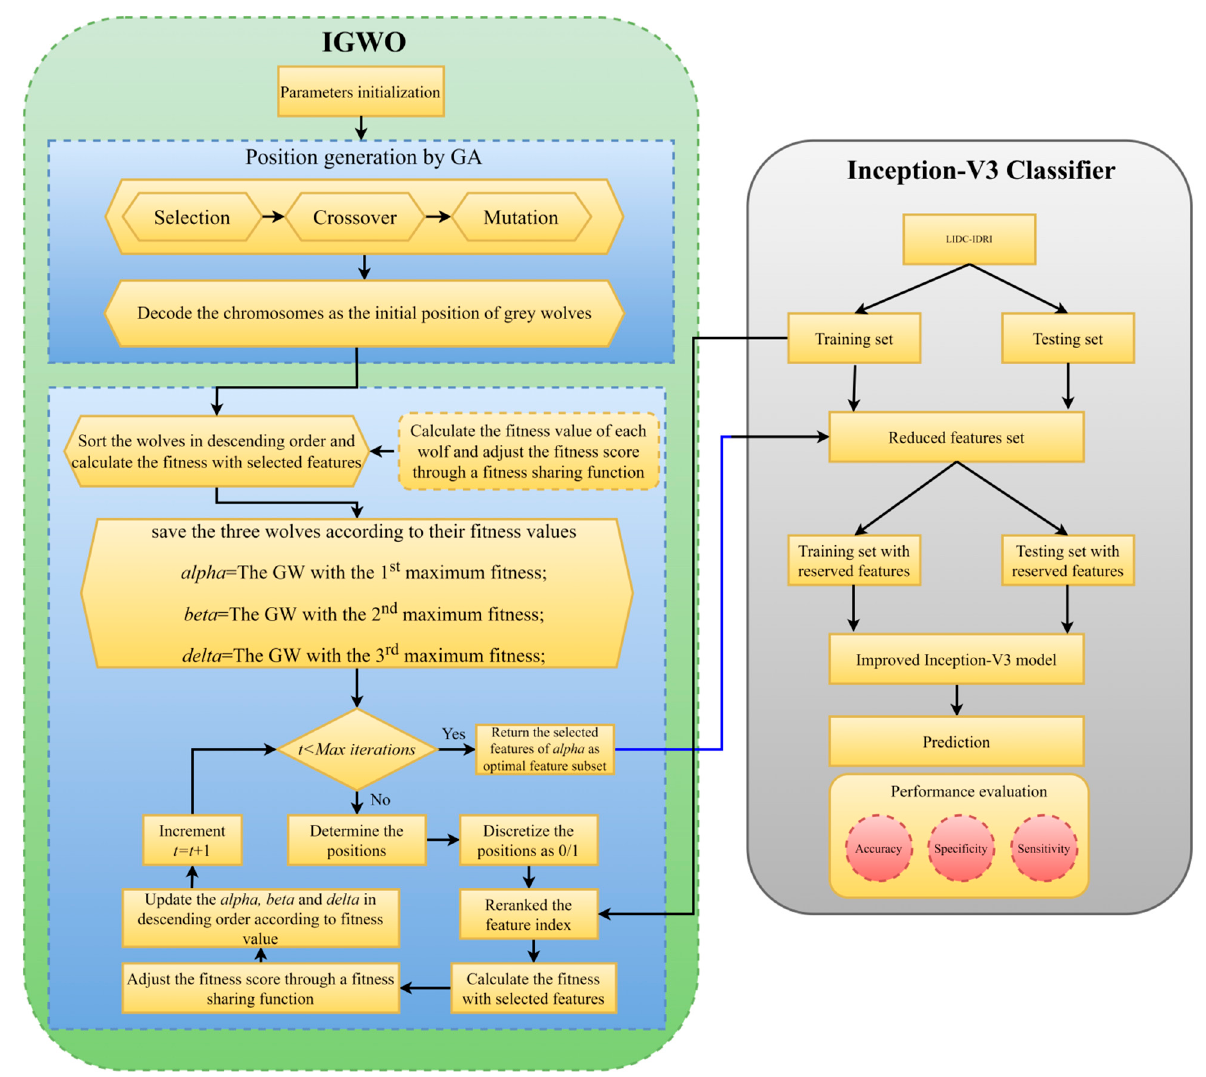
Figure 6. Proposed IGWO-CNN flowchart.